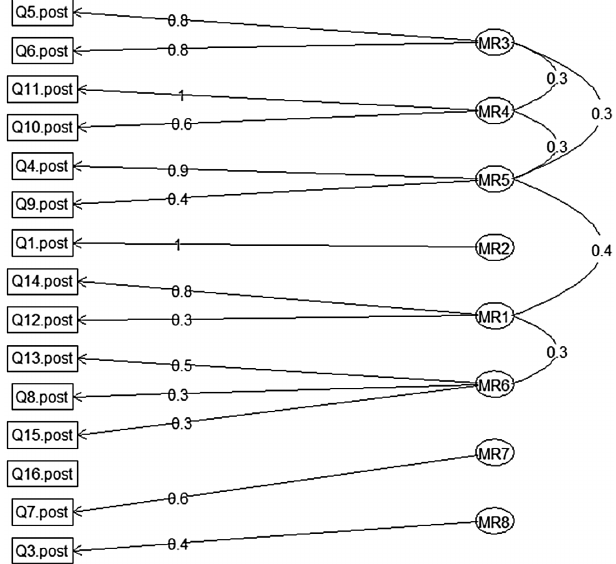
FIG. 8. Distribution of the 15 ROC-CI items to the 8 factors MR1-MR8 determined in an exploratory factor analysis. The connecting arches on the right indicate correlations between the single factors, which were allowed in this model due to the oblique rotation used in the analysis. indicate that this item does not fit well to the factor and 1 indicates a perfect fit of this item to the factor. The 8 factors can be matched with the subscales as indicated in Table V. Factor MR3 (containing Q5 and Q6) refers to the core concept “ Left-right and top-bottom swap ” (TB). Factor MR4 (containing Q10 and Q11) refers to the core concept “ Diameter of the lens ” (DL). Factor MR5 (containing Q4, Q9, and possibly Q16) refers to the core TABLE V. Cronbach ’ s alpha values for the subscales containing more than one item.